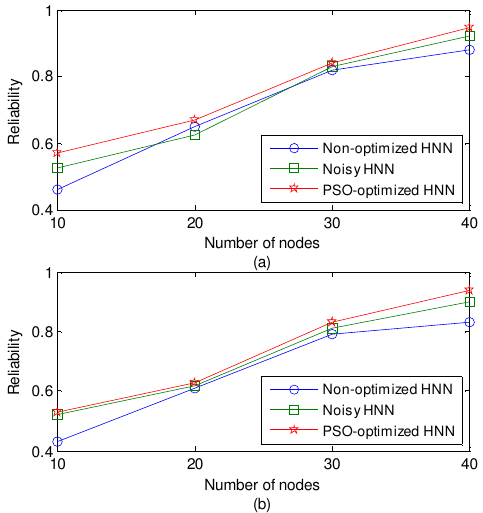
Fig. 7. Lifetime of selected paths by different HNN-based algorithms; a) Link-disjoint, b) Node-disjoint.